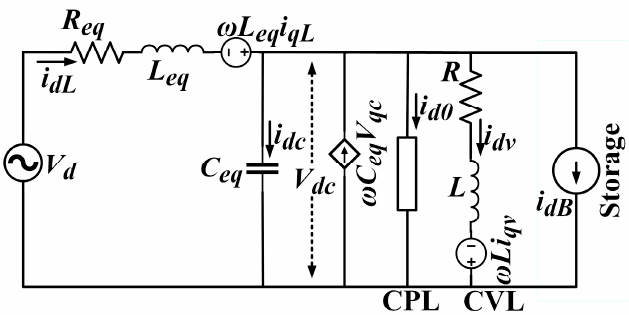
Figure 4. Real power compensation method at the load side, modeled for d -axis.